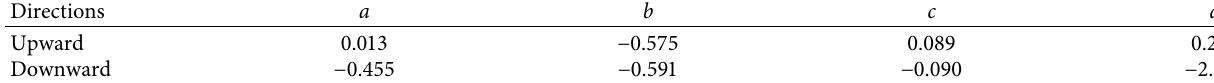
Table 4: Te values of the constants under diferent fow directions in equation (13).